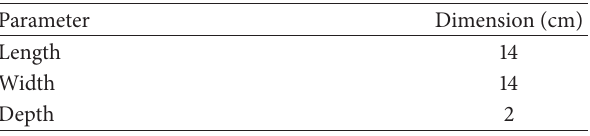
Table 2: Transducer dimensions.